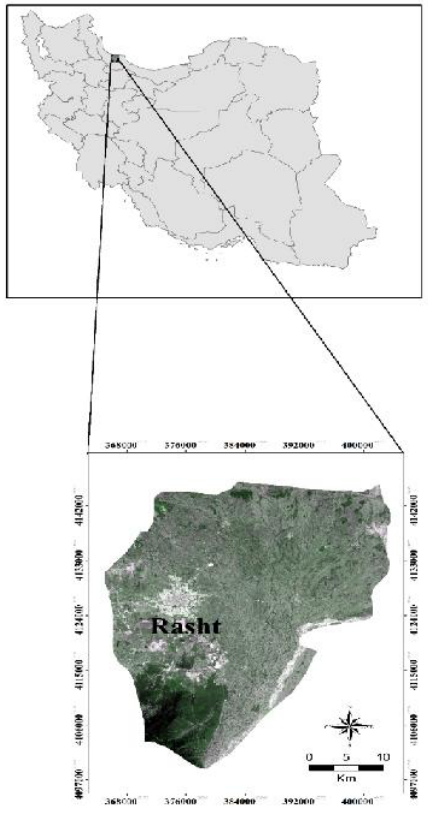
Figure 1. Study area, Rasht,